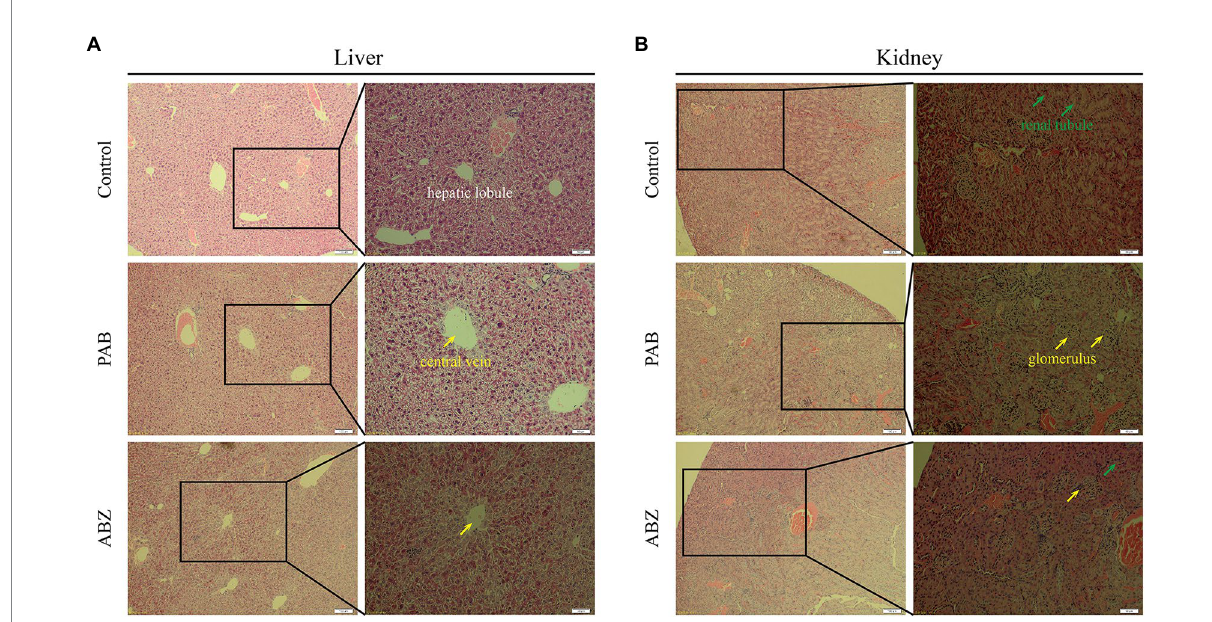
FIGURE 8 Hepatotoxicity and nephrotoxicity of PAB in mice. (A) Liver and (B) kidney histopathological images from Kunming mice treated with 40 mg/kg PAB and 100 mg/kg ABZ for 6 weeks (100 × and 200 × magnification), as detected by HE staining assay.